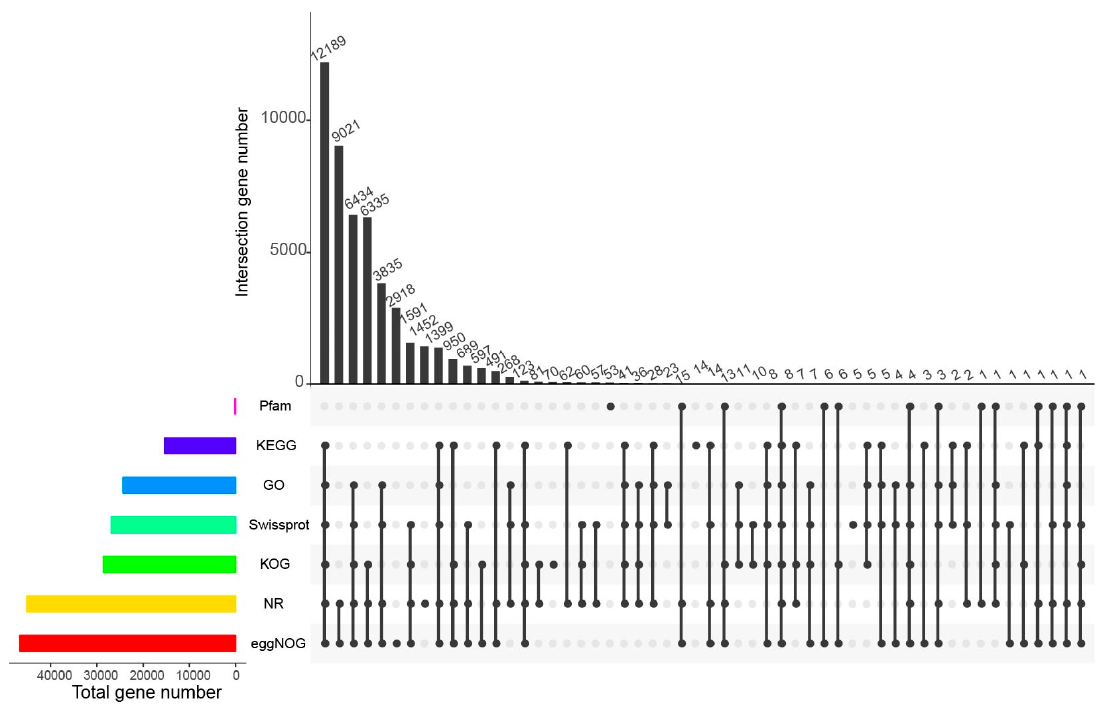
Figure 1. Unigenes functional annotation. The numbers on the top bar represent the results of the intersection of databases with black dots in the matrix below, and the columns on the left represent the total number of genes annotated to each database.